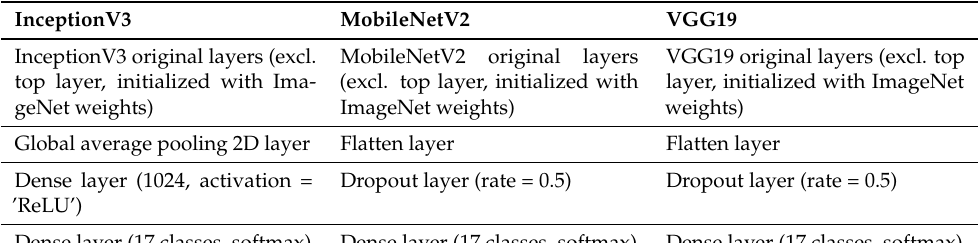
Table 2. The layer configuration used for the training of the CNNs.